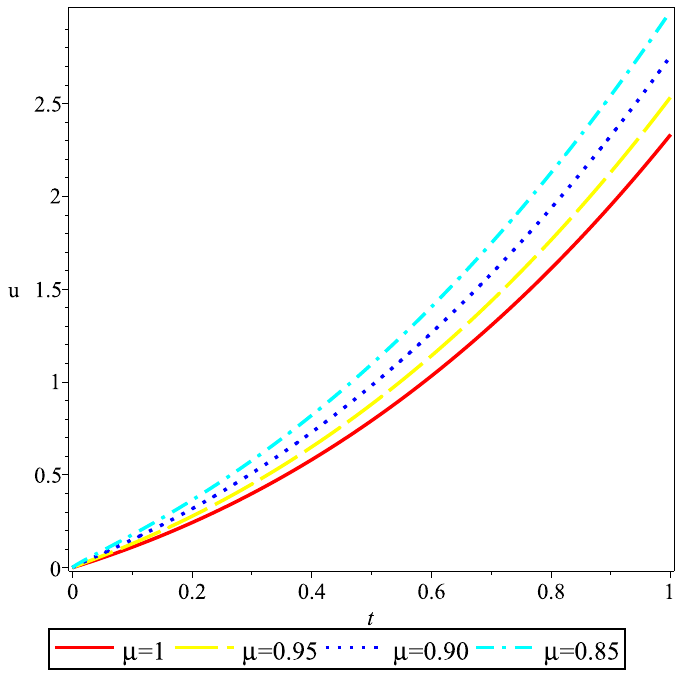
Figure 2. Response of u ( t ) with respect to t for distinct values of µ .